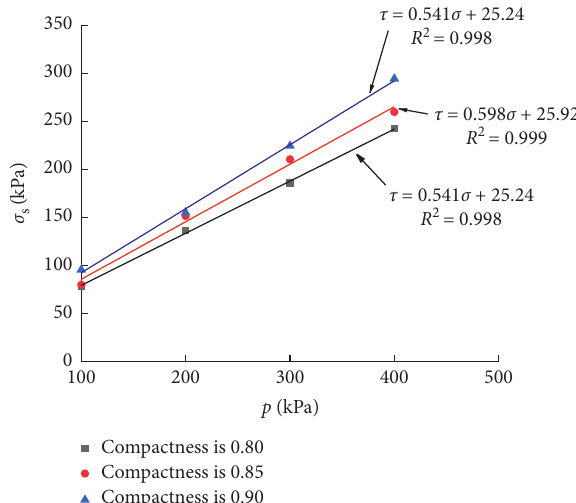
Figure 20: Relationship between shear strength and normal stress levels of reinforced bamboo tendon grating soils with varying